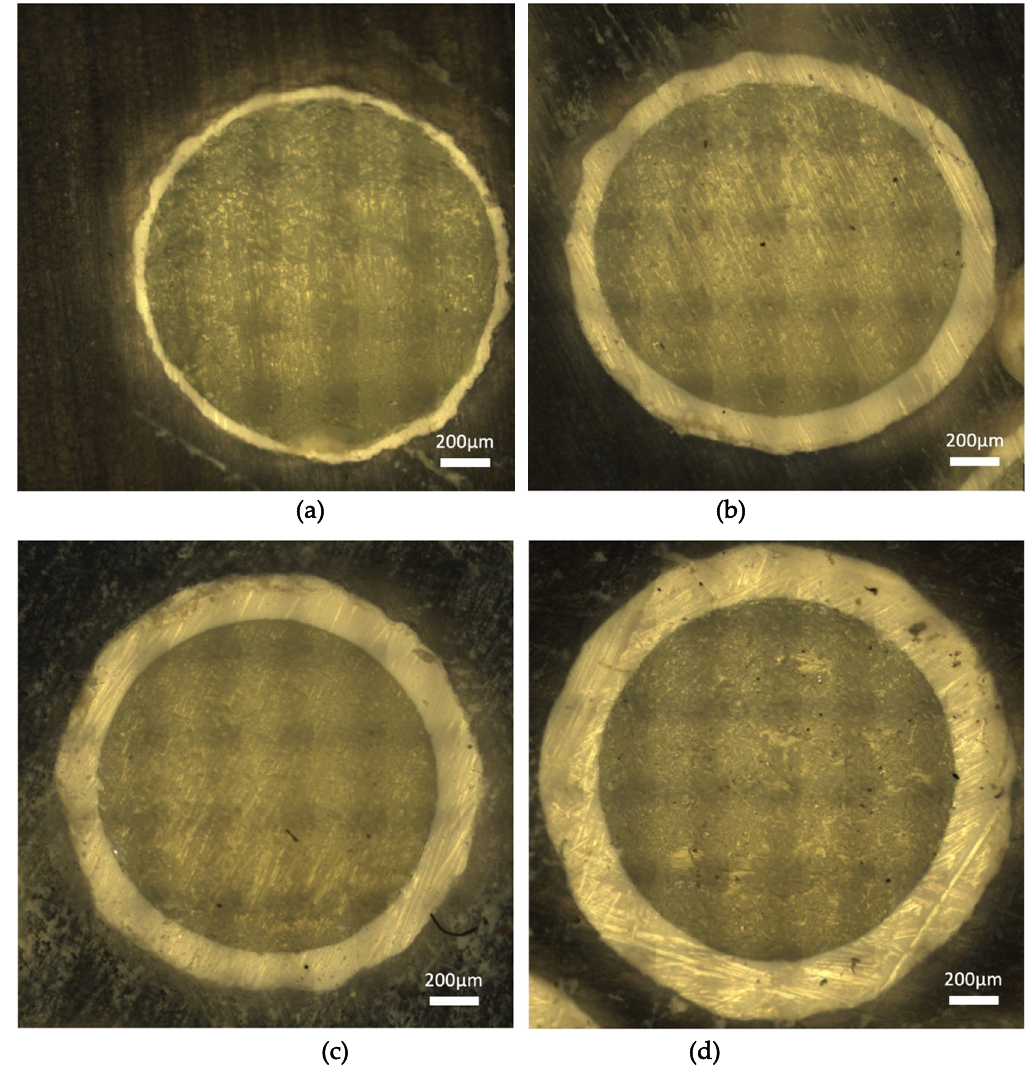
Figure C1. Example of four layer thicknesses of BaTiO 3 @SiO 2 core-shell spheres; (a): 50 µm; (b): 130 Figure A2. Example of four layer thicknesses of BaTiO 3 @SiO 2 core-shell spheres; ( a ): 50 µ m; ( b ): 130 µ m; µm; (c): 180 µm; (d): 230 µm. ( c ): 180 µ m; ( d ): 230 µ